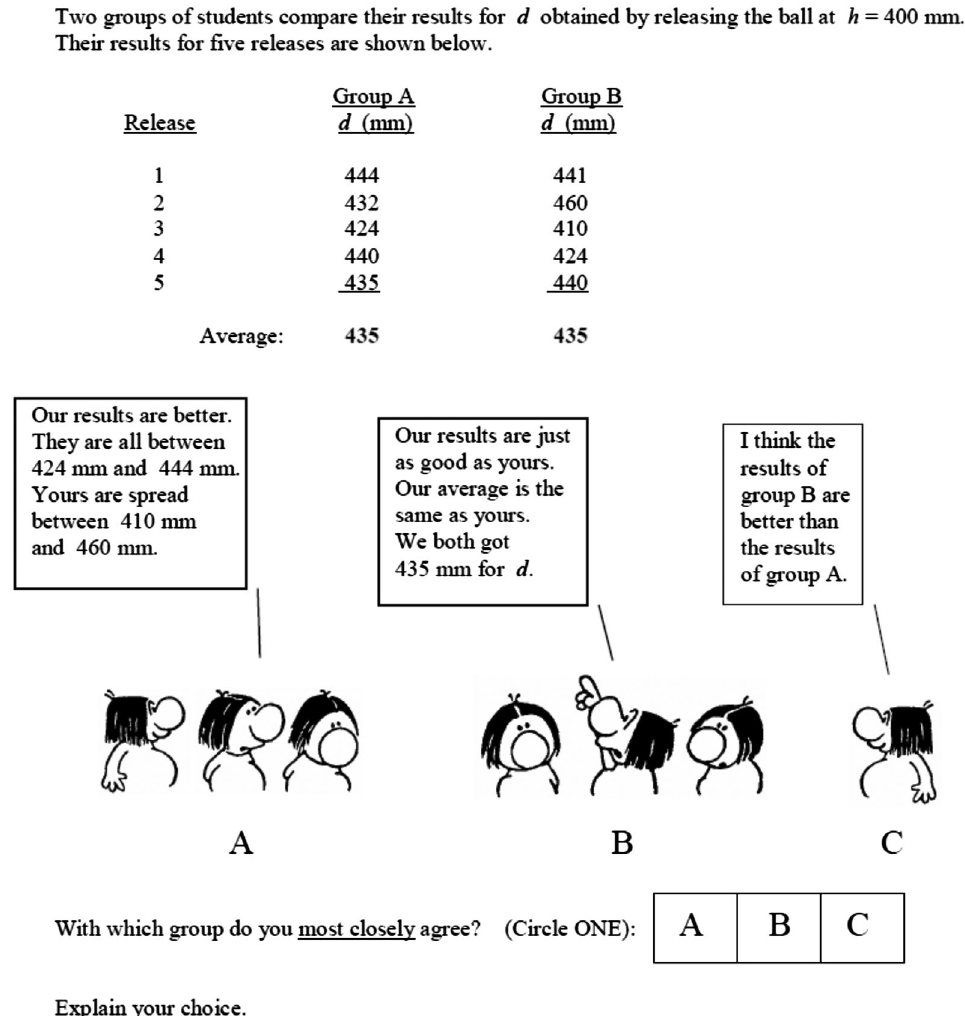
FIG. 10. The SMDS probe of the PMQ. Reproduced from Ref.